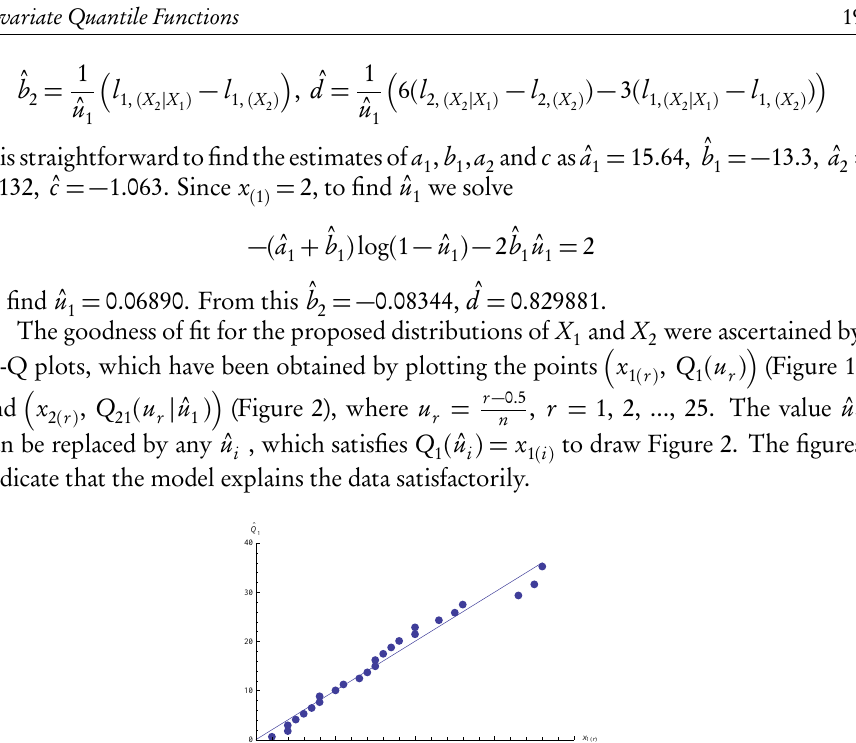
Figure 1 – Q-Q Plot obtained by plotting ( x